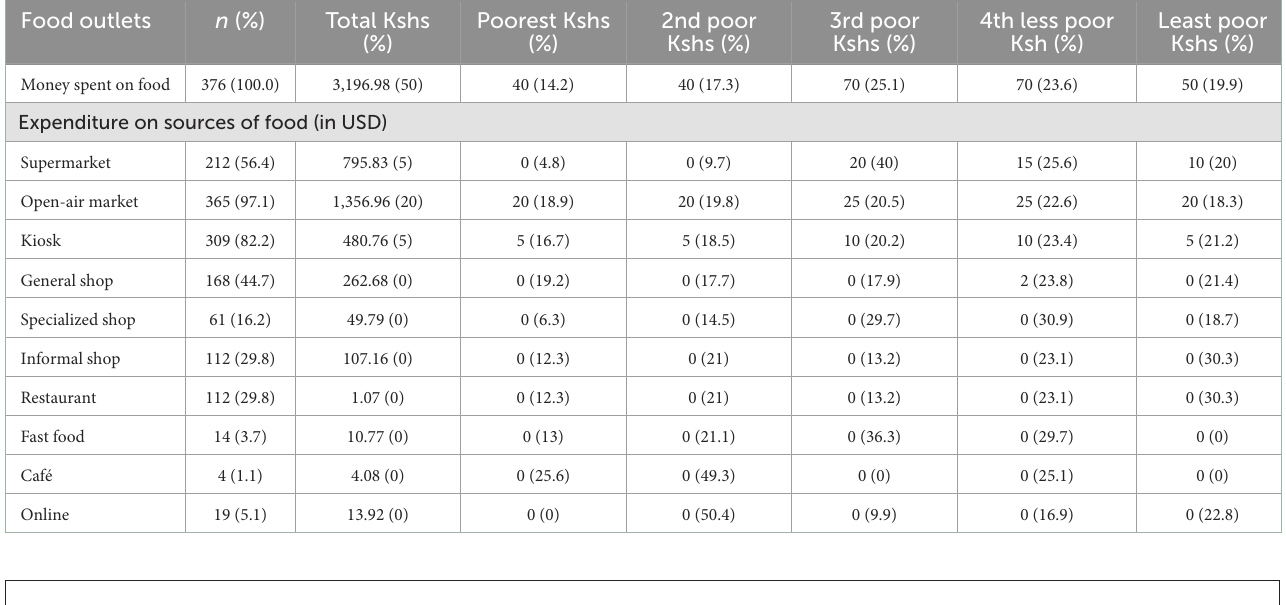
TABLE 6 Median monthly expenditure and proportion of expenditures in food outlets stratified by socioeconomic status in hypermarket study, Western Region, Kenya ( n = 376).